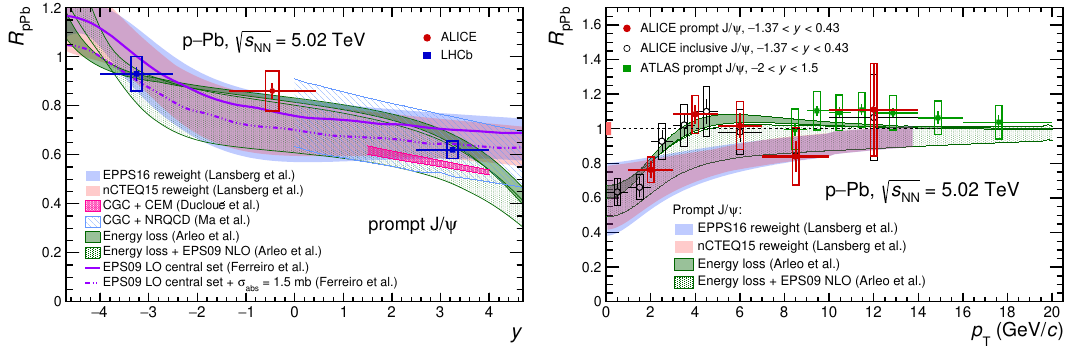
Figure 7 . R of prompt J /ψ as a function of rapidity (left panel) and as a function of p pPb T along with that of inclusive J /ψ at midrapidity (right panel). Results are shown in comparison with LHCb measurements [64] at backward and forward rapidity in the left panel and with ATLAS results [14] (shown up to p = 20 GeV/ c ) in the right-hand panel. Statistical uncertainties are T represented by vertical error bars, while open boxes correspond to systematic uncertainties. In the left panel, the systematic uncertainty of the ALICE data point includes also the contribution from the extrapolation procedure to go from the visible region ( p > 1 GeV/ c ) to p > 0 . The T T filled box around R = 1 in the right panel indicates the size of the global relative uncertainty of pPb the ALICE measurements. The results of various model predictions for prompt J /ψ implementing different CNM effects are also shown [44, 101,